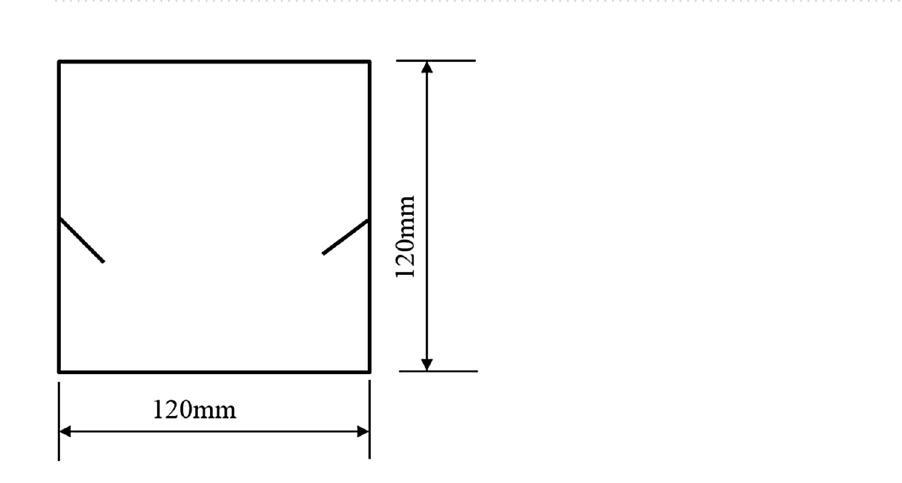
Figure 9. Precast crack orientation 6. Fissure length 2 cm, horizontal angle of fissure 40°.